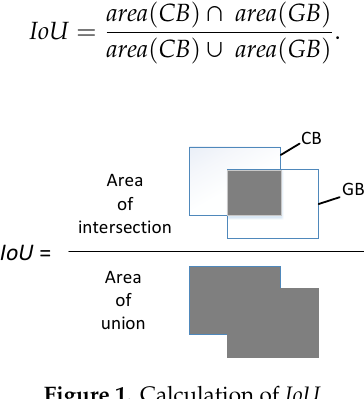
Figure 1. Calculation of 𝐼𝑜𝑈 .